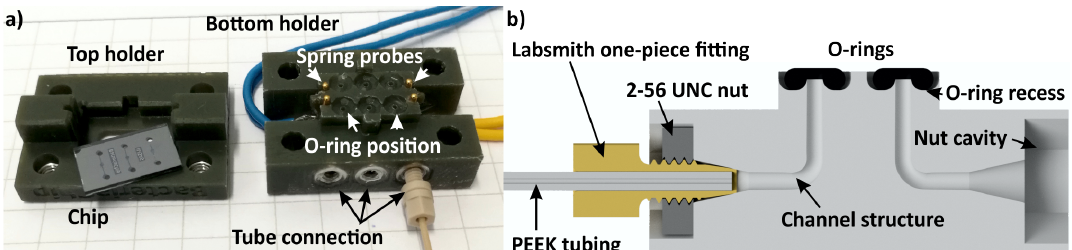
Figure 6. ( a ) A photo of a microfluidic chip holder (19mm × 26.5mm × 10mm) with six fluidic and four electric connections. The fluidic outer connection is realized by placing 2-56 UNC metal nuts at the end of a channel structure. The chip (7mm × 12mm × 1mm) has three measurement chambers that are deep reactive-ion etched in a silicon wafer. The chambers are closed by an anodically-bonded borosilicate glass wafer. ( b ) A 2D cut to visualize the fluidic inner channel structure and Labsmith one-piece fitting connection.